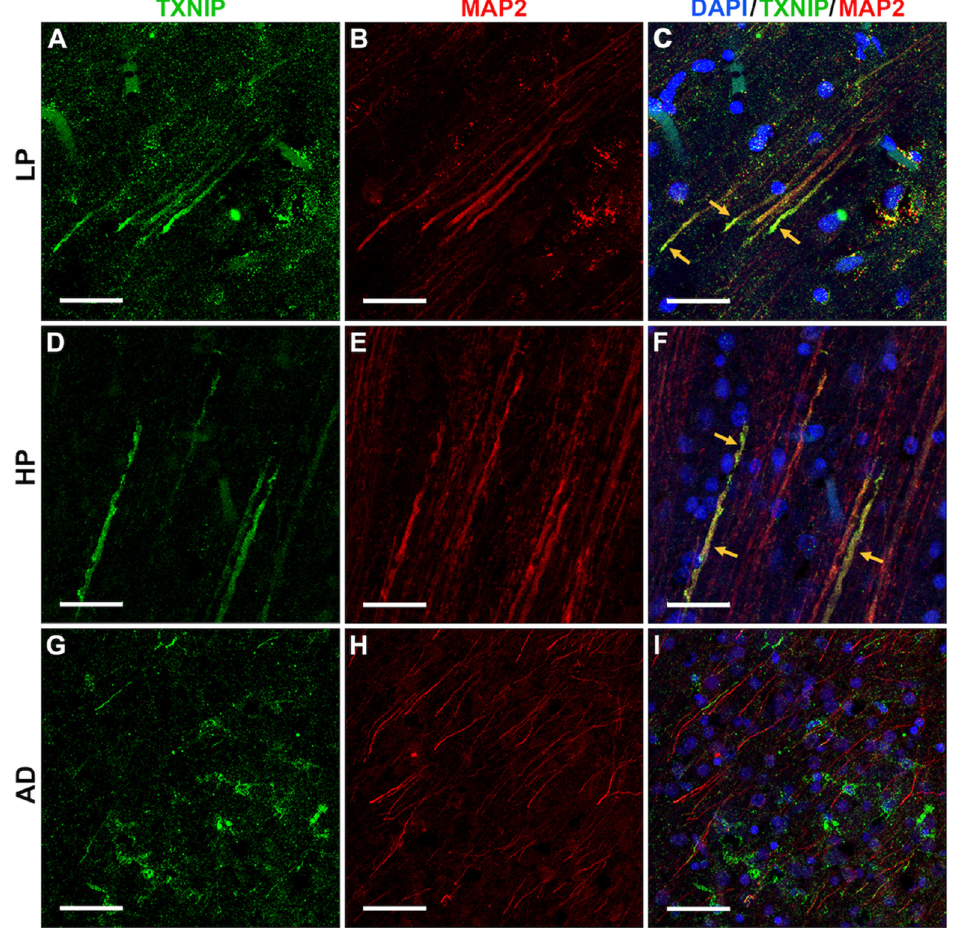
Figure 6. Confocal microscopy showing extensive colocalization of TXNIP with MAP2 immunoreactivity. All sections shown were from middle temporal gyrus. ( A – C ) LP case showing ( A ) TXNIP immunoreactivity (green), ( B ) MAP2 immunoreactivity (red), and ( C ) merged image (yellow arrows) with DAPI staining (blue). ( D – F ) HP case showing ( D ) TXNIP immunoreactivity (green), ( E ) MAP2 immunoreactivity (red), and ( F ) merged image, indicated by yellow arrows with DAPI staining (blue). ( G – I ). AD case showing ( G ) TXNIP immunoreactivity (green), ( H ) MAP2 immunoreactivity (red), and ( I ) merged image showing TXNIP-positive cells with limited colocalization with MAP2 with DAPI staining (blue). Bars represents 30 µ